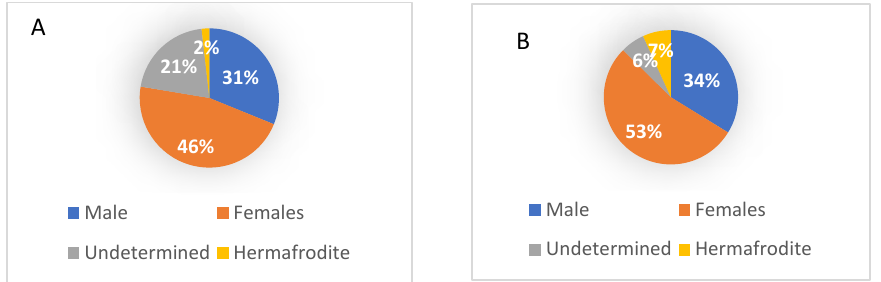
Figure 2. Proportion of males, females, undetermined sex and hermaphrodites of Pinctada capensis ( A ) and Saccostrea cucullata ( B ).